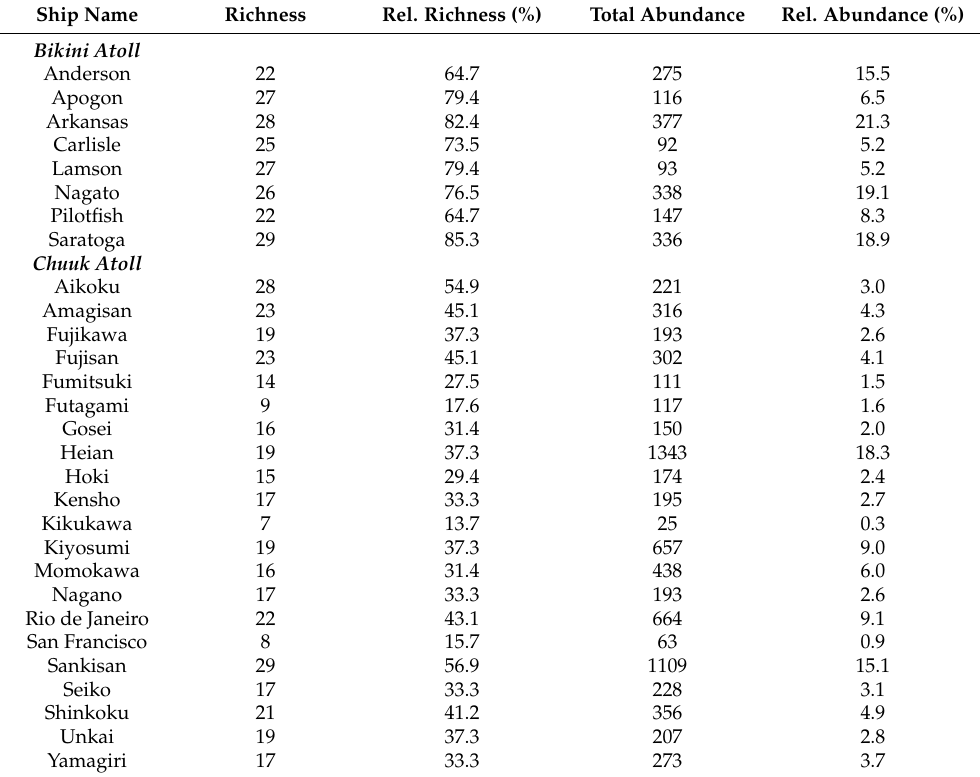
Table 2. Coral genus-level richness and abundance by